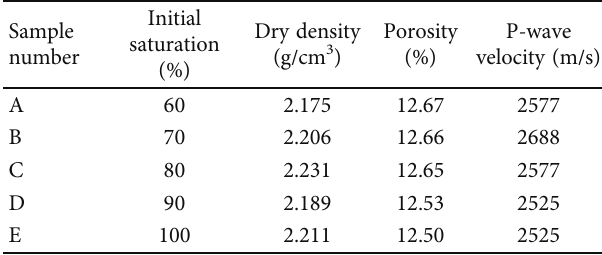
Figure 1: Geometry of the fracture space. Table 1: Rock sample numbers and basic